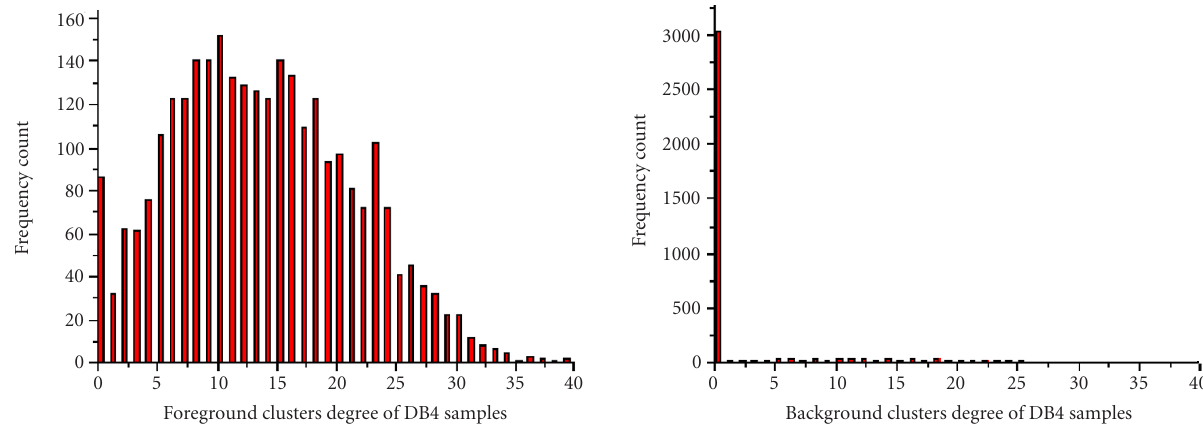
Figure 8: The block clusters degree CluD of the samples. The horizontal coordinate represents the value of the block clusters degree while the vertical coordinate represents the frequency count of the value.